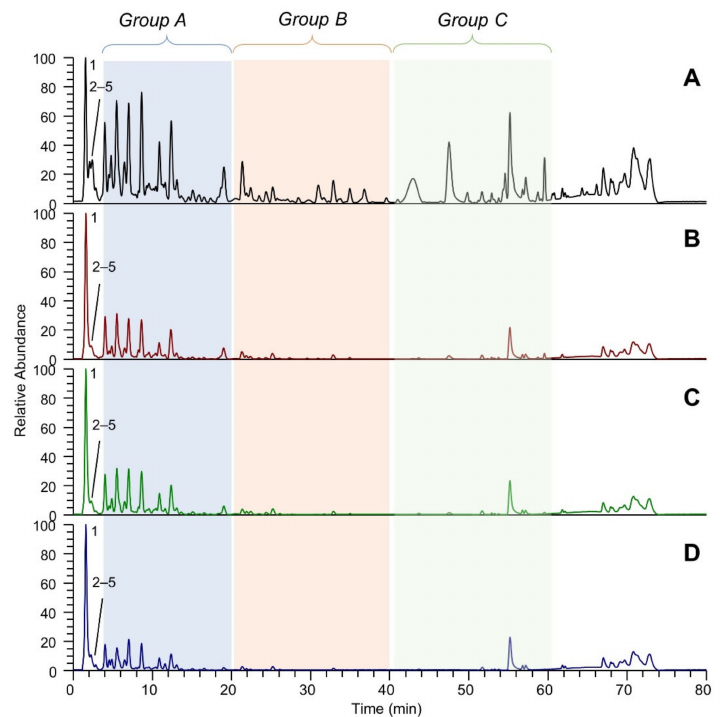
Figure 1. LC-ESI-(-)-MS total ion currents (TICs) in negative ion mode of the four extracts: ( A ) EtOH-H 2 O 70:30 (% v / v ); extract A; ( B ) water at 100 ◦ C, extract B; ( C ) water at 70 ◦ C extract C; ( D ) water at room temperature, extract D. Peaks numbered from 1 to 5 eluted within 3 min and are not included in the groups A, B and C which are magnified in Figures 2–4.